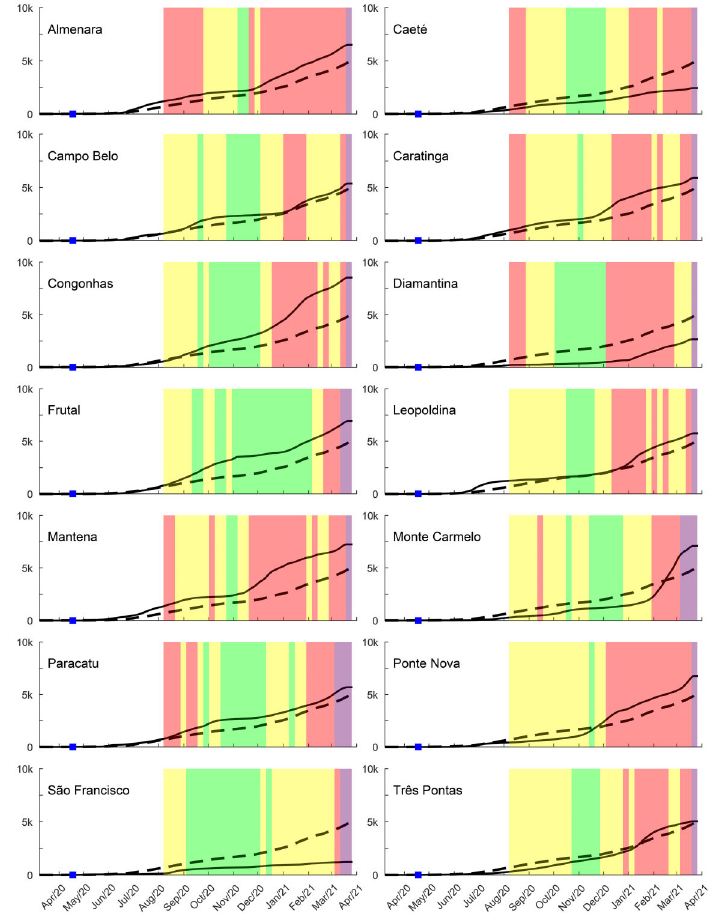
Figure 5. COVID-19 prevalence (per 100k inhabitants) for the 14 municipalities of Minas Gerais (MG) state macro-regions (full lines) contrasted with the whole MG state (segmented lines). The colored bands from August 2020 to March 2021 represent the color wave codes de fi ned by the Conscious Minas Plan. The fi rst con fi rmed case within each macro-regions is shown as a blue square mark.